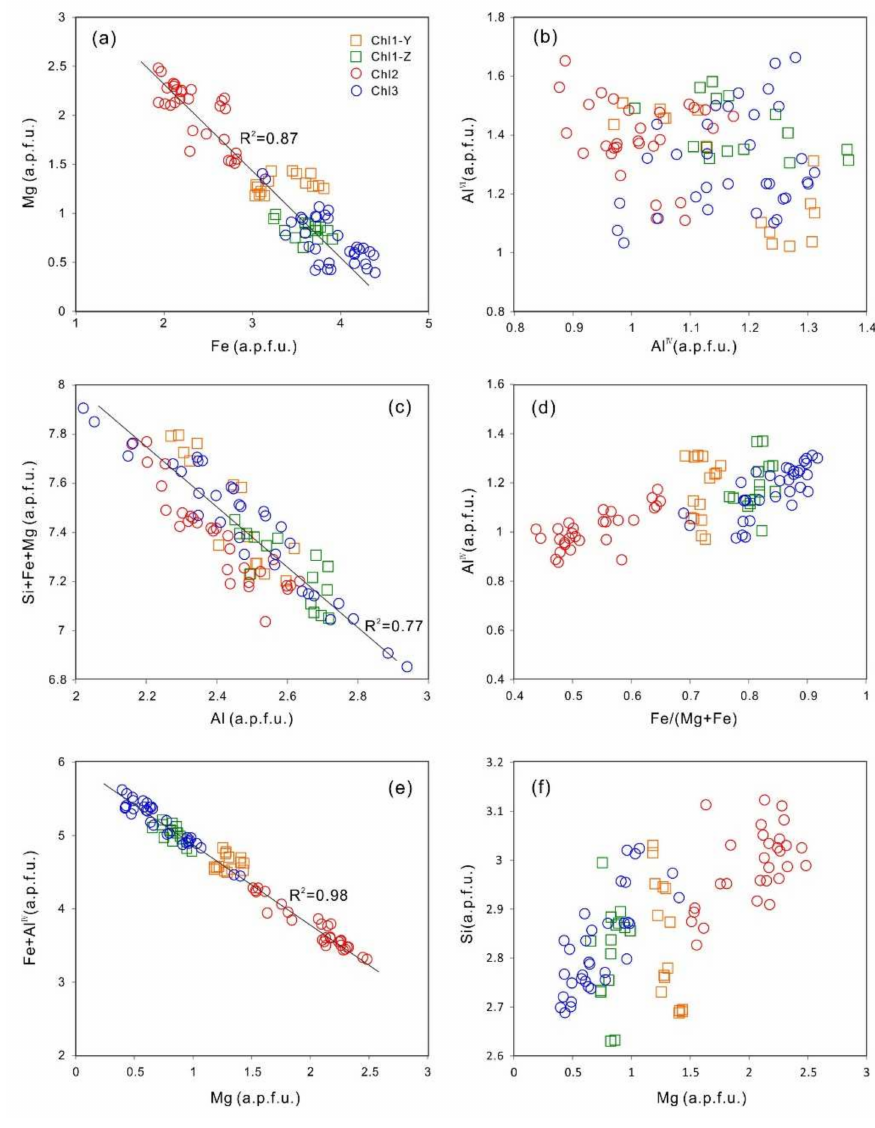
Figure 7. Binary diagram of chlorite at the Zoujiashan deposit and Yunji deposit (calculated based on 14 oxygen atoms, a.p.f.u.) ( a ) Fe vs. Mg; ( b ) Al VI vs. Al IV ; ( c ) Al vs. Si + Fe + Mg; ( d ) Fe/(Mg + Fe) vs. Al IV ; ( e ) Mg vs. Fe + Al; ( f ) Mg vs.